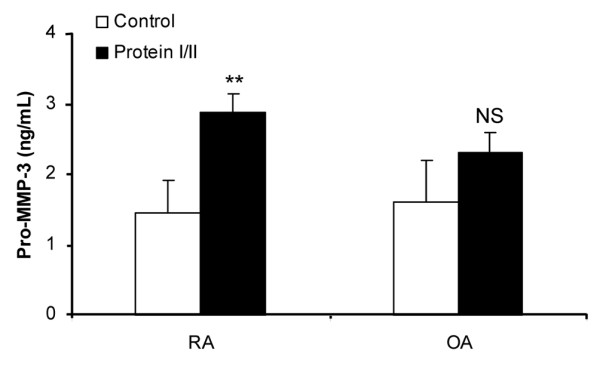
Protein-I/II-induced release of pro-matrix metalloproteinase (pro-MMP-3) from rheumatoid arthritis (RA) fibroblast-like synoviocytes (FLSs) and osteoarthritis (OA) FLSs. The level of pro-MMP-3 was determined in culture supernatants from control RA FLSs stimulated for 18 hours with protein I/II (n = 3) and OA FLSs (n = 3), using heterologous two-site sandwich ELISA. ELISA was performed in duplicate. Experiments were performed in duplicate. Values are expressed as means ± standard error of the mean. Statistical comparison of protein-I/II-stimulated and control samples was performed using the t-test (**P < 0.01; NS, not significant).